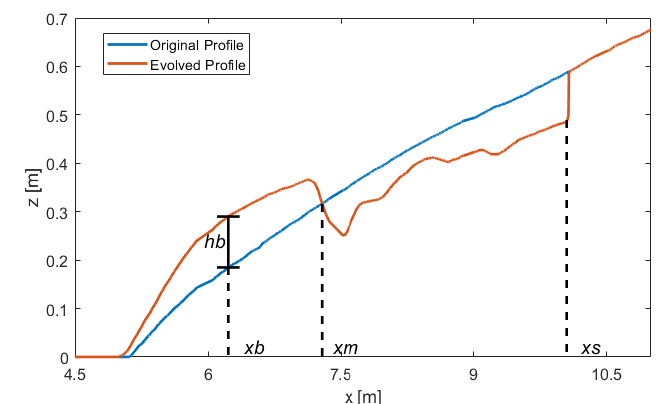
Figure 3. Dimension of the sandbar and the scarp ( xb and hb are the location and height of the bar; xm is the intersection of original and evolved profiles; xs is the location of scarp).